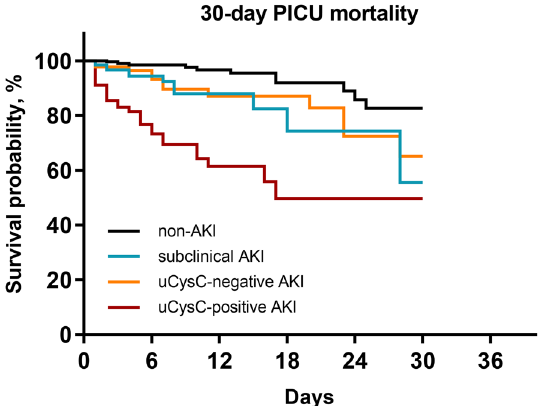
Fig. 5 Kaplan–Meier survival curves of the four groups during the follow-up period of 30 days. Statistical significance was reached both when all four groups were considered ( P < 0.001) and when only two groups (non-AKI vs. subclinical AKI, non-AKI vs. AKI substage A, non-AKI vs. AKI substage B, subclinical AKI vs. AKI substage B, AKI substage A vs. AKI substage B) were compared ( P <